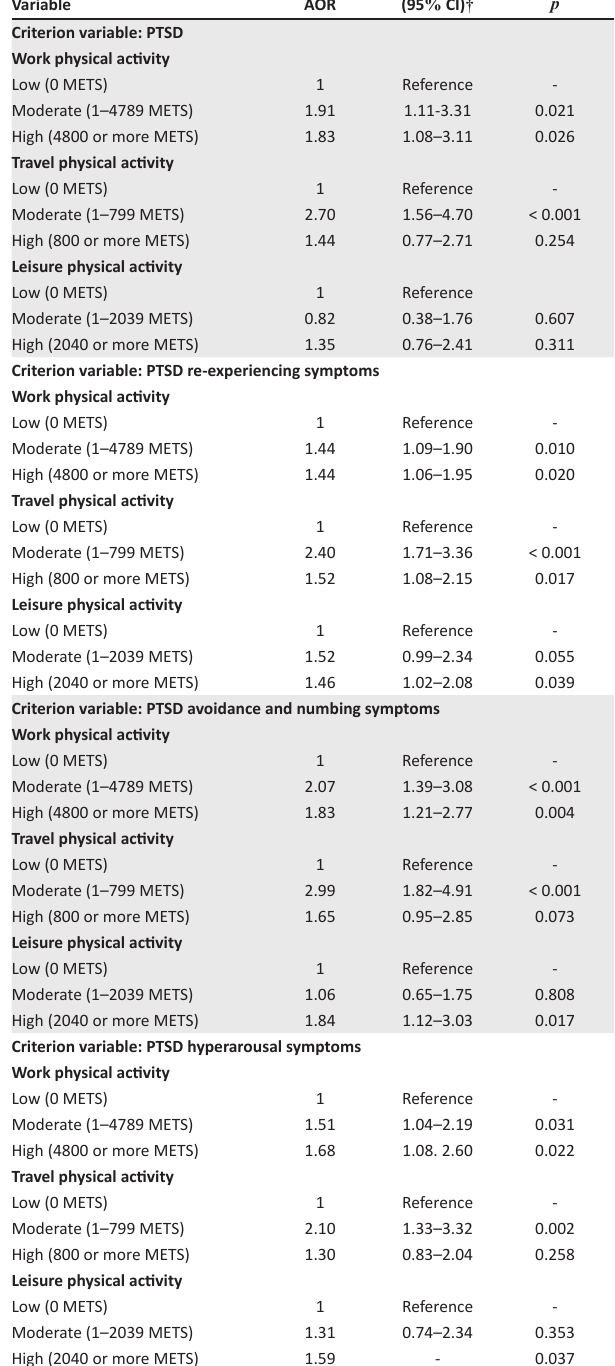
TABLE 3: Associations between domains of physical activity levels and PTSD ( N = 13469).